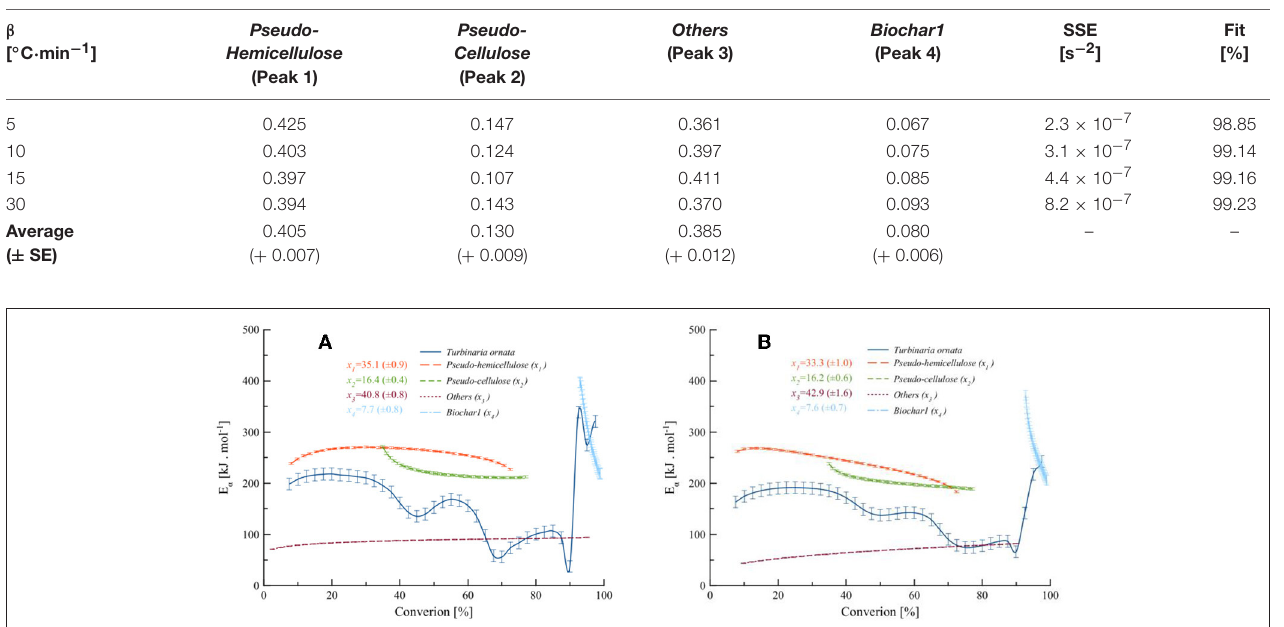
TABLE 6 | Fractional mass loss (x j ) of deconvoluted Turbinaria ornata pseudo-components using FS distribution at different heating rates.